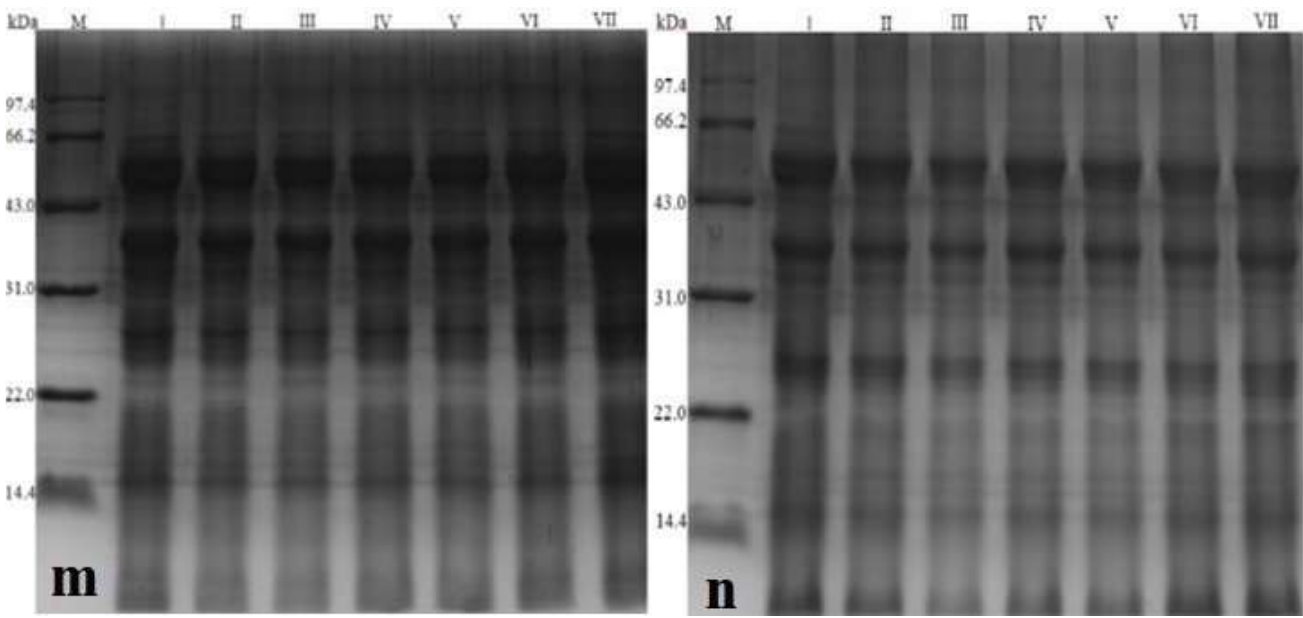
Figure 6. Sodium Dodecyl Sulfate-Polyacrylamide Gel Electrophoresis (SDS-PAGE) of dry-heat-treated rice bran protein. ( a , b ) represent non reduced electrophoresis and reduced electrophoresis analysis of untreated rice bran (RB) protein, respectively; ( c , d ) are expressed as non-reductive electrophoresis and reductive electrophoresis analysis of RB protein treated at 120 °C for 233 min, respectively; ( e,f ) are expressed as non-reductive electrophoresis and reductive electrophoresis analysis of RB protein treated at 120 °C for 143 min, respectively; ( g , h ) are expressed as non-reductive electrophoresis and reductive electrophoresis analysis of RB protein treated at 120 °C for 88 min, respectively; ( i , j ) are expressed as non-reductive electrophoresis and reductive electrophoresis analysis of RB protein treated at 130 °C for 86 min, respectively; ( k , l ) are expressed as non-reductive electrophoresis and reductive electrophoresis analysis of RB protein treated at 130 °C for 66 min, respectively; ( m , n ) are defined as non-reductive electrophoresis and reductive electrophoresis analysis of RB protein treated at 130 °C for 50 min, respectively; Lanes I–VII represent RB samples stored at 25 °C for 0, 10, 20, 30, 40, 50, and 60 days, respectively.